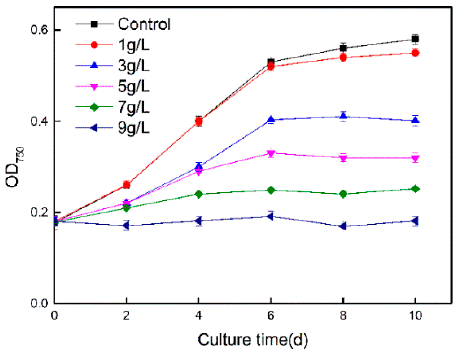
ff erent concentrations of